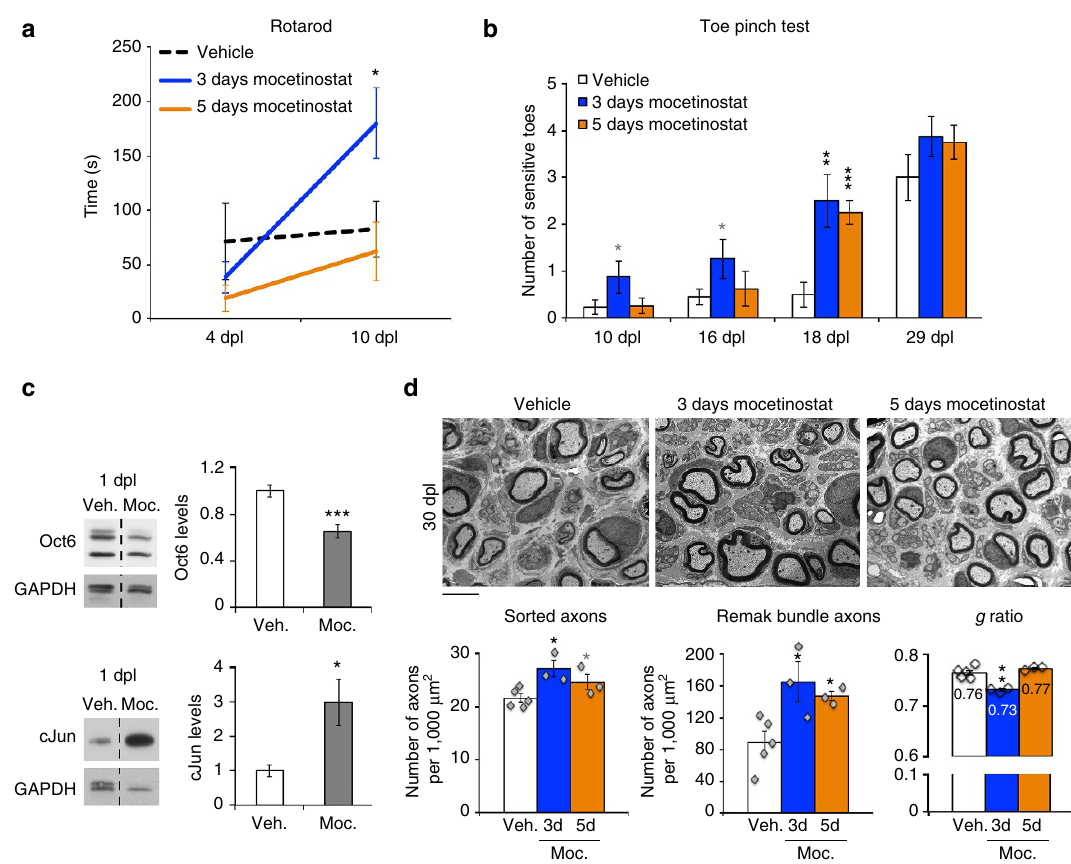
Figure 9 | HDAC1/2 inhibitor treatment accelerates functional recovery. Quantification of motor function recovery by Rotarod test at 4 and 10 dpl ( a ) and of sensory function recovery by toe pinch test at 10, 16, 18 and 29 dpl ( b ) in vehicle, 3-day or 5-day Mocetinostat-treated mice after sciatic nerve lesion. ( c ) Western blot of Oct6 and cJun and quantification normalized to GAPDH showing reduced Oct6 and increased cJun levels in nerves of mice treated with Mocetinostat (Moc.) for 1 day after lesion compared to vehicle (Veh.). ( d ) Electron micrographs of nerve ultrathin sections from vehicle, 3-day and 5-day Mocetinostat-treated mice and quantification showing increased density of sorted (mostly myelinated) axons and Remak bundle axons in both Mocetinostat-treated groups and increased myelin thickness at 30 dpl in the 3-day Mocetinostat-treated group, compared with vehicle (Veh.). Scale bar, 5 m m. One-tailed (grey asterisks) or two-tailed (black asterisks) unpaired Student’s t -tests, P values: * P o 0.05, ** P o 0.01, *** P o 0.001. Values, mean; error bars, s.e.m. Asterisks show significance compared with the vehicle group. Sample size: ( a , b ) Vehicle, 9 animals; 3-day Mocetinostat, 8 animals;